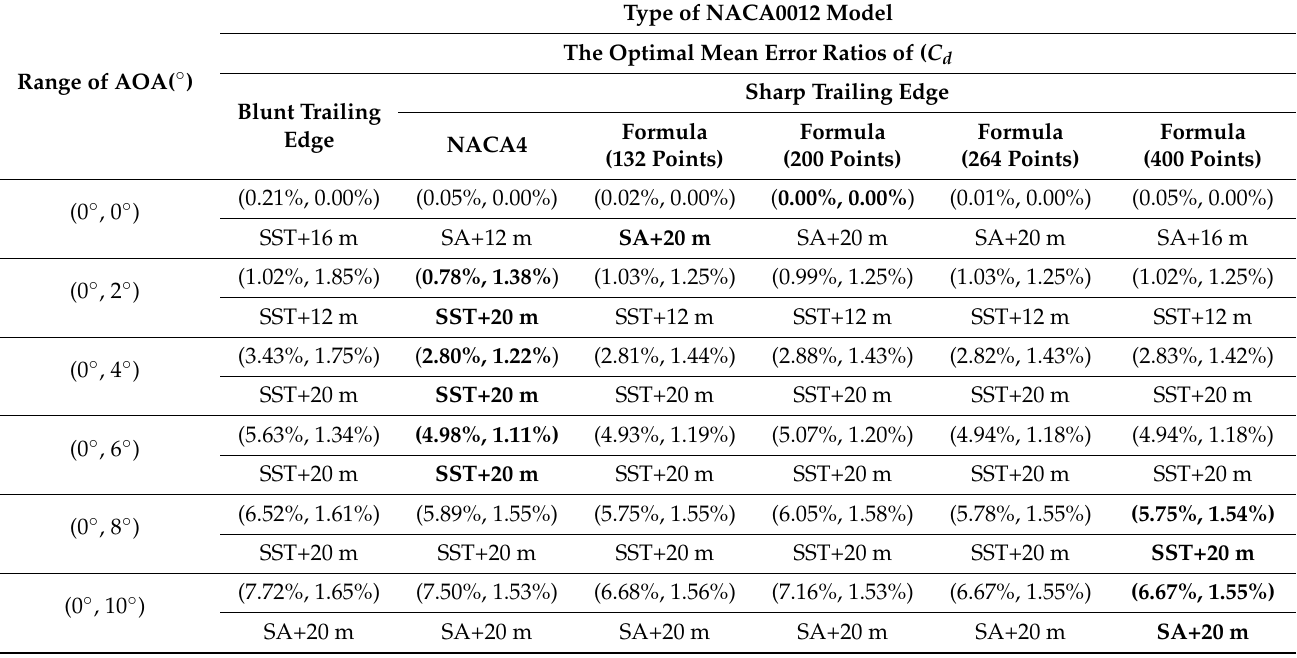
Figure 20. The optimal total error ratios of turbulence models and the corresponding calculation accuracy improvements. Table 19. The optimal results and the corresponding simulation